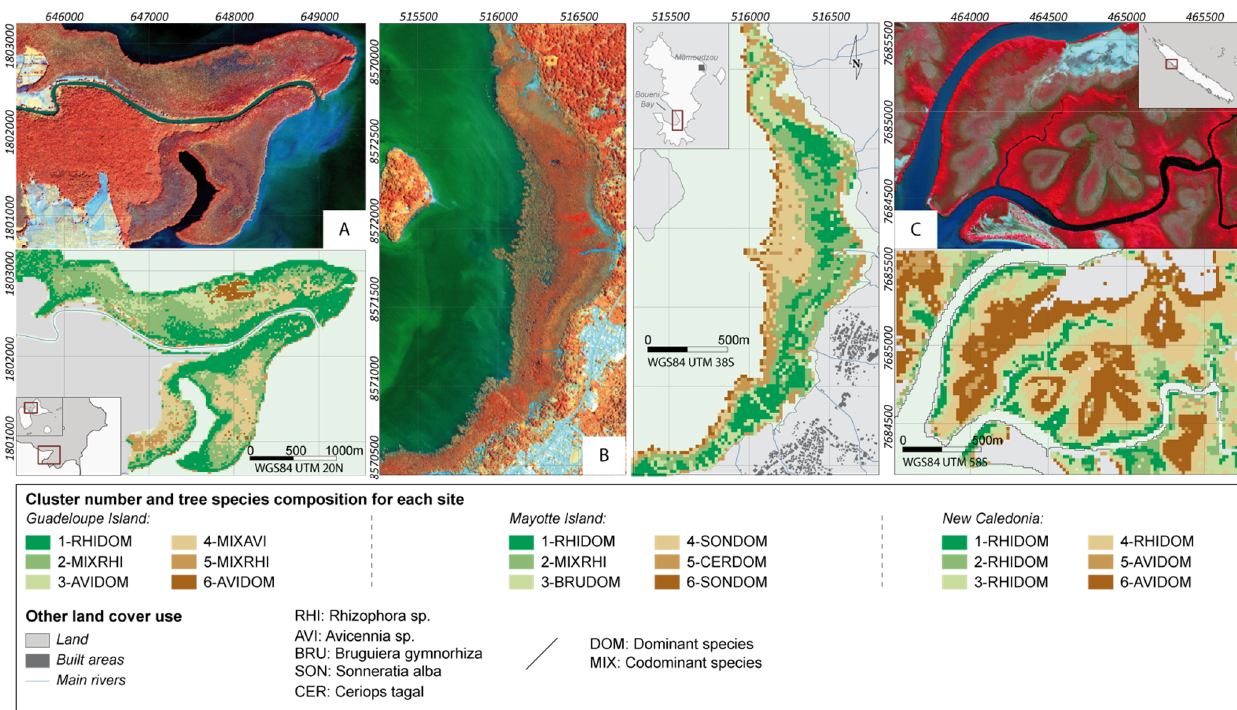
Figure 6. K-mean classifications (6 clusters) of mangrove vegetation structures based on fractions for the three sites.